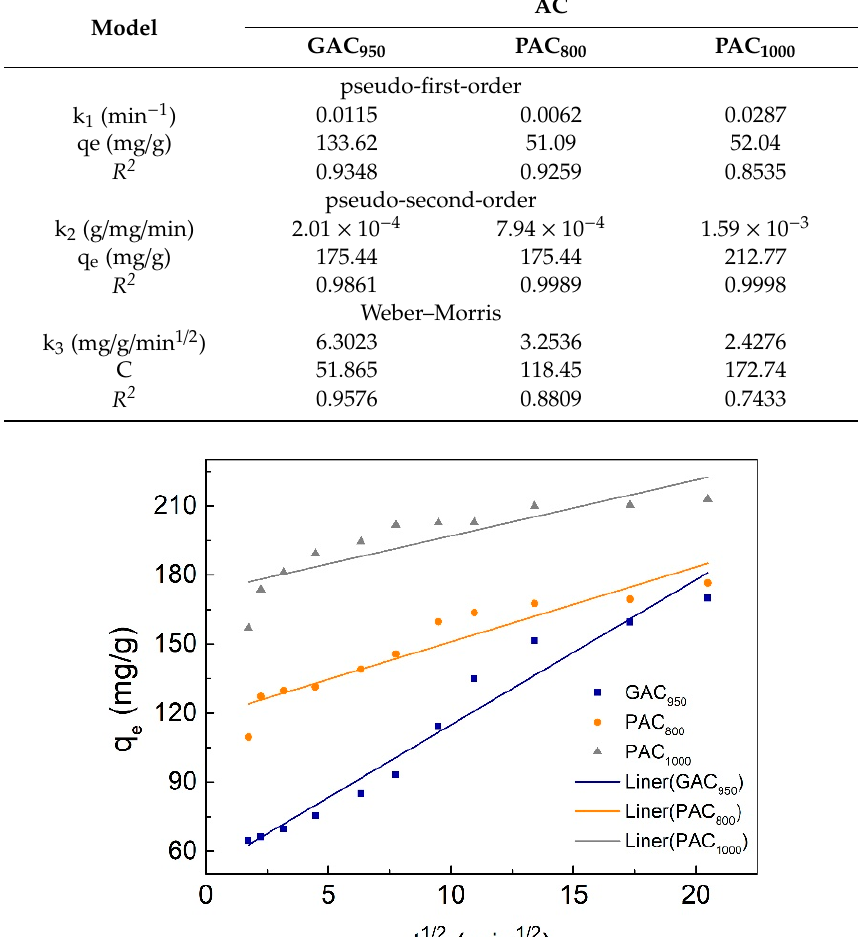
Table 1. Kinetic parameters for phenol adsorption onto AC.